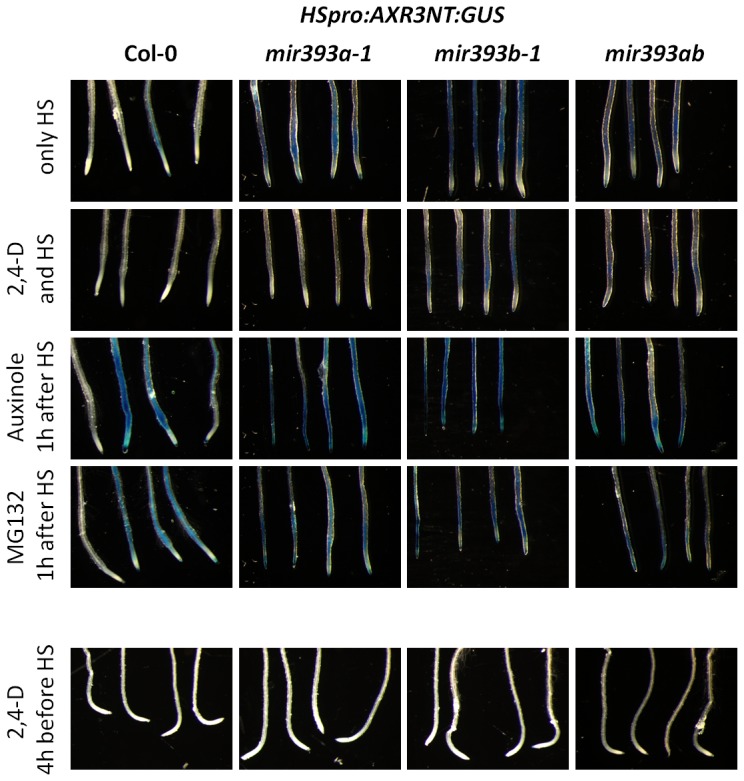
miR393 is required for proper degradation of AXR3-NT:GUS proteins.Representative pictures of wt and mir393 mutant roots expressing the HSpro:AXR3-NT:GUS gene. Without treatments, the AXR3-NT:GUS fusion protein is more stable in mir393a-1, mir393b-1 and mir393ab mutants compared to wt plants. Short treatments with 10 µM auxin induces the degradation of AXR3-NT:GUS, while treatment with 20 µM auxinole or MG132 blocks the degradation of AXR3-NT:GUS. This shows that the SCF complexes and proteasome are functional in the mutants as well. Clearance of presumably high levels of endogenous AUX/IAA proteins by treatment with 2,4-D for 4 h restores the proper degradation of AXR3-NT:GUS.